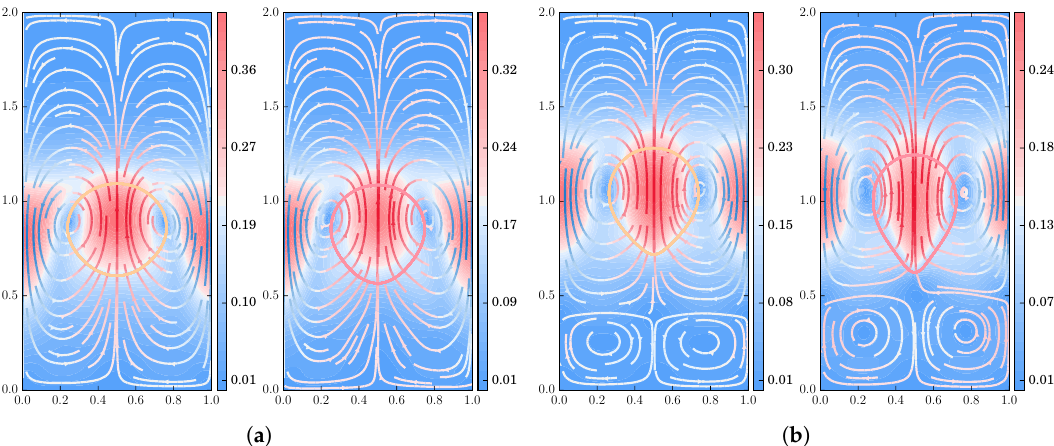
Figure 15. Drop shape and streamlines for the FENE model ( b = 50), with ρ 2 / ρ 1 = 10 − 1 = µ 2 / µ 1 at different instants of time: ( a ) t = 2 and ( b ) t = 3. For each panel, the left figure (yellow line) shows the streamlines for c = 5, De = 3; the right figure (red line), those for c = 9, De = 5.